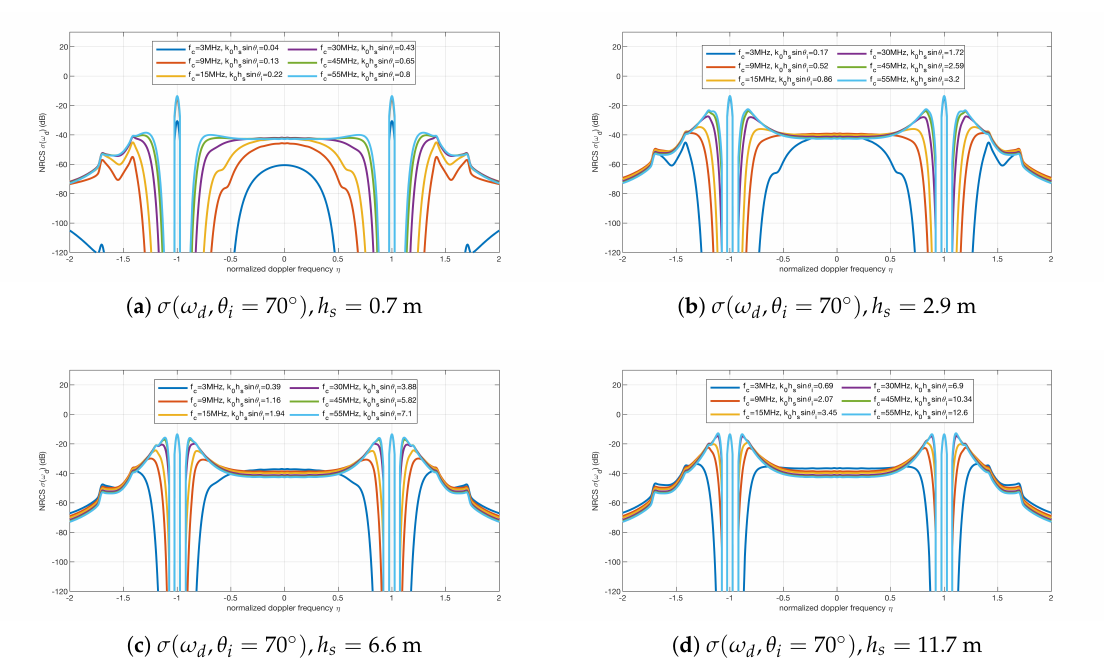
Figure 6. The Doppler spectra for θ i = 70 ◦ with different f c and h s . ( a ) σ ( ω d , θ i = 70 ◦ ) , h s = 0.7 m; ( b ) σ ( ω d , θ i = 70 ◦ ) , h s = 2.9 m; ( c ) σ ( ω d , θ i = 70 ◦ ) , h s = 6.6 m; and ( d ) σ ( ω d , θ i = 70 ◦ ) , h s = 11.7 m. For each pair of θ i and h s , six radar frequencies were selected to simulate the spectra. The six values of f c were 3, 9, 15, 30, 45 and 55 MHz. The dominant wave direction α (cid:48) is 90 ◦